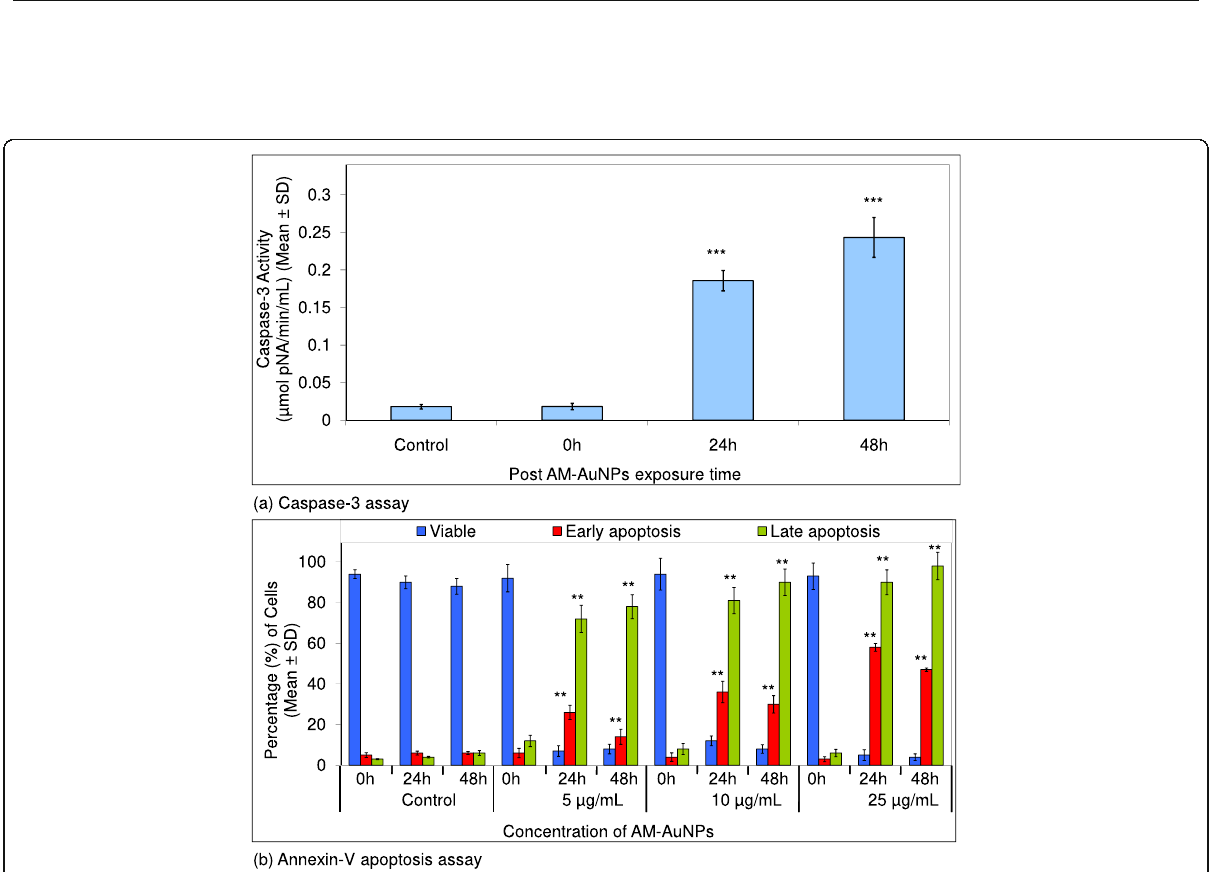
Fig. 6 a Representative histogram showing caspase-3 activity in HCT-15 cells. Error bars indicate the standard deviation of three independent experiments ( n = 3). Levels of significance in caspase-3 activity, μ molpNA/min/ml between control and AM-AuNPs exposed cell samples assessed by Student ’ s t test are marked by *** p < 0.0001, which was found to be increased significantly in protein samples obtained from 24 h and 48 h post exposure periods as compared to control cell samples. b Histogram showing analysis of Annexin V-FITC-PI staining of AM-AuNP-treated HCT-15 cells for 0, 24, and 48 h. Data presented were expressed as mean ± SD. Significant differences are indicated ** p < 0.001 found to be increased significantly in cell samples obtained from 24 and 48 h post exposure to AM-AuNPs as compared to normal control